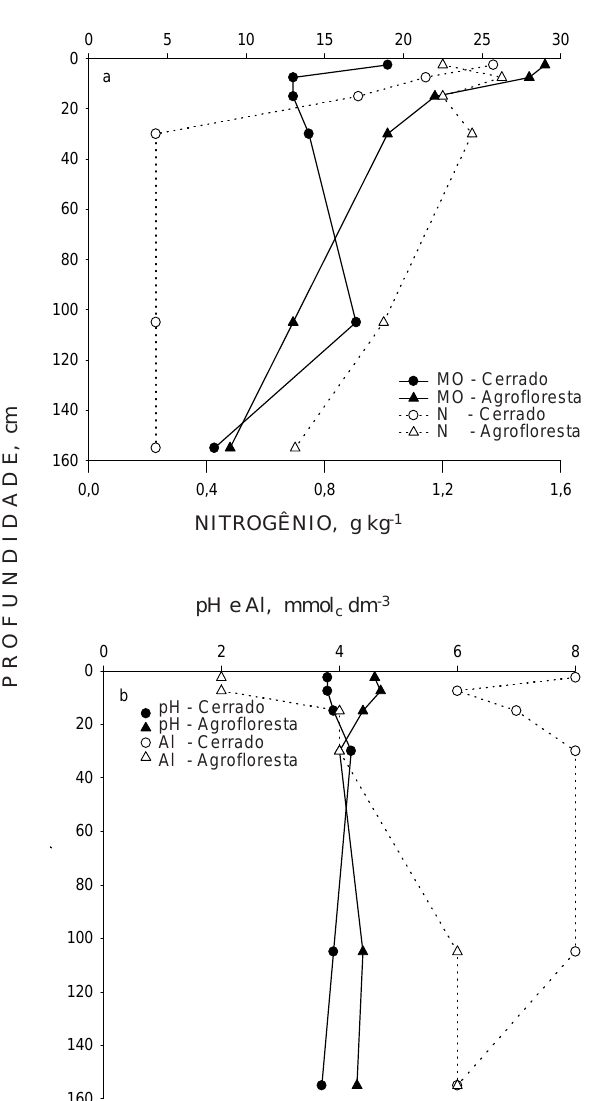
Figura 1. Atributos químicos do solo sob cultivo em aléias e no cerrado (a) Matéria orgânica e nitrogênio, (b) pH e